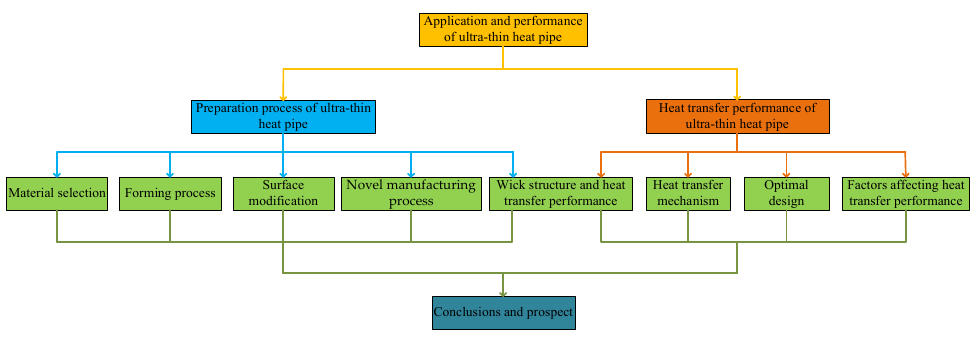
Figure 3. The framework structure of this paper.